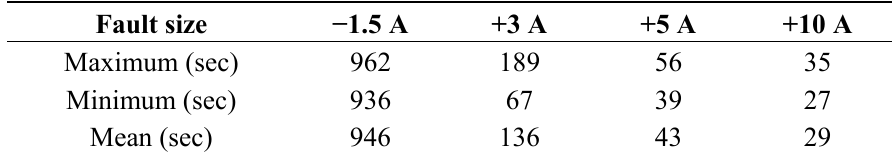
Table 2. Detection time for current sensor fault under UDC and DST tests.